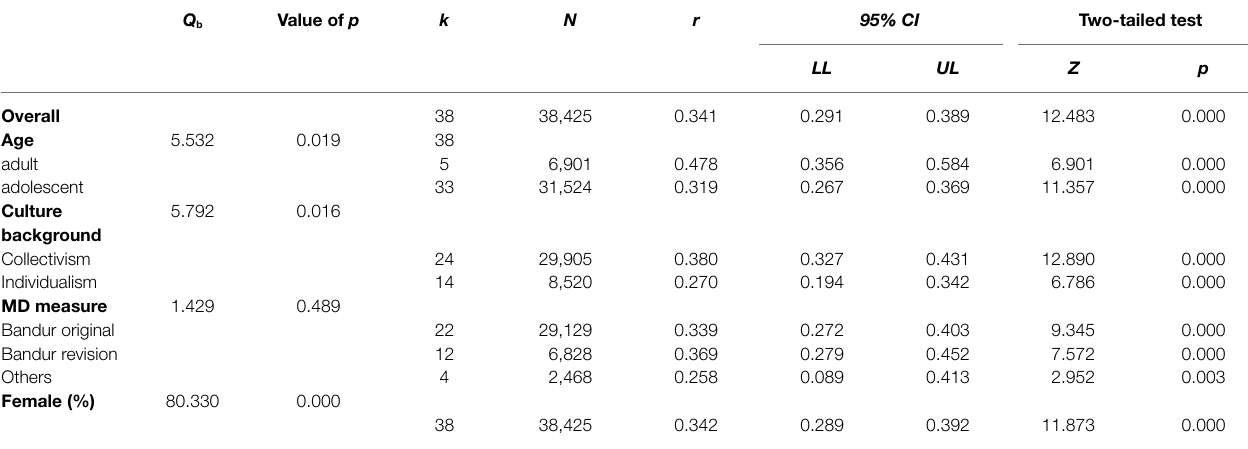
TABLE 3 | Summary and the moderating effect test between moral disengagement and cyberbullying. Q b